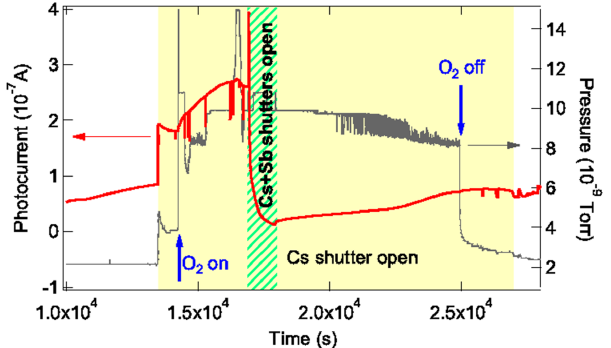
FIG. 3. Typical growth parameters of a Cs-Sb-O coated GaAs sample. Left axis: Photocurrent; the shaded area represents the time interval where the Cs shutter was kept open, the striped area is when both Cs and Sb were codeposited. Right axis: Total pressure during deposition. The base pressure before opening the shutters and the oxygen valve was 2 . 2 × 10 − 9 Torr.